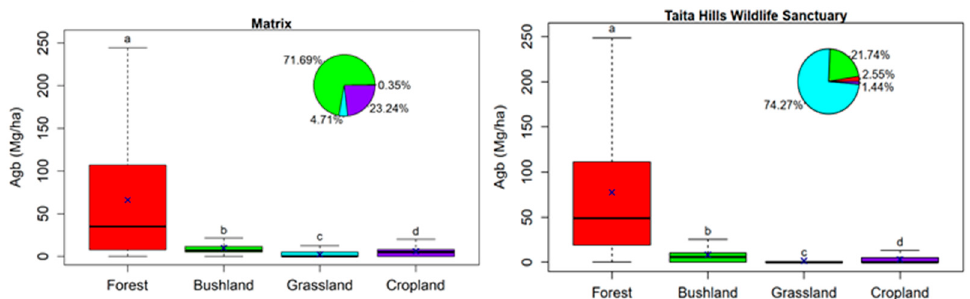
Figure 7. Land cover class-wise distribution of aboveground biomass (AGB) for each land-use region. Letters indicate significant differences (p < 0.05) according to the Dunn test. The outliers in each box plot are not shown. The pie chart shows the distribution of the types in the study area. The “x” on each box plot represents the means and the whiskers represent confidence intervals. Table 3. Aboveground biomass (AGB) statistics for land-use regions and land cover types based on